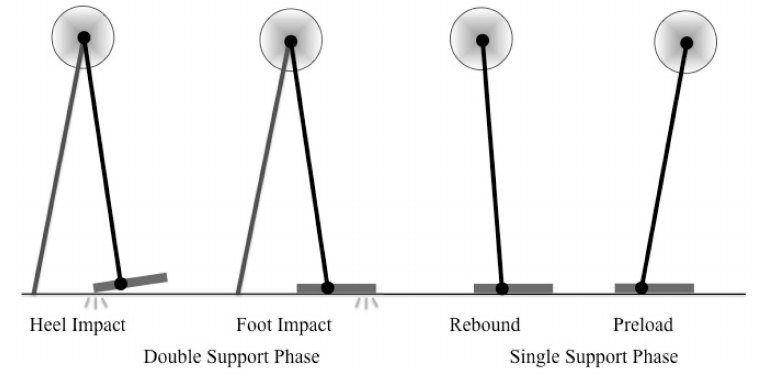
Figure 14. Modeling of one bipedal walking step.